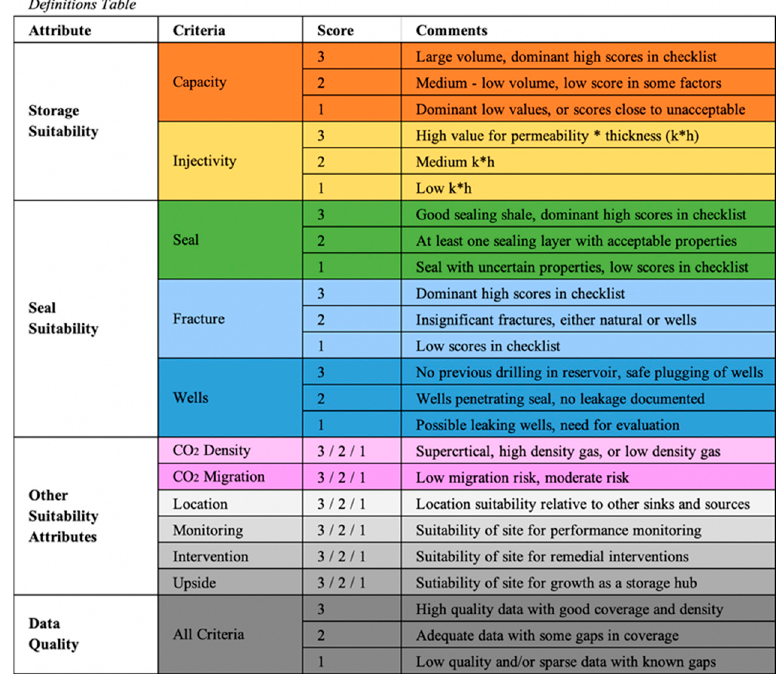
Figure A1. Guide ranges for principle attribute quality [71,82].